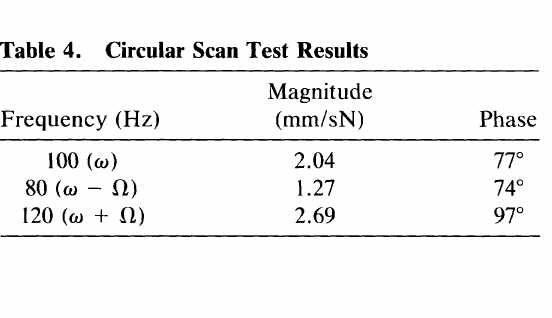
Table 4. Circular Scan Test Results